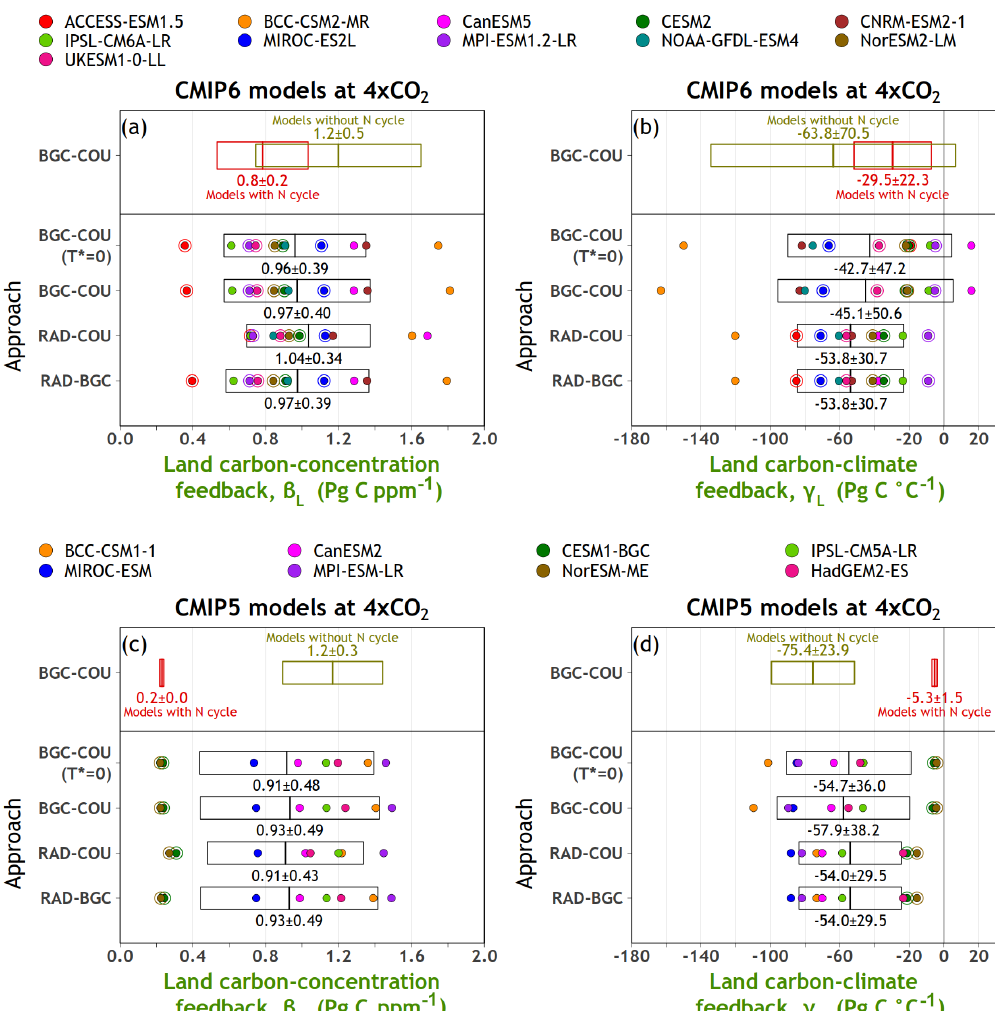
Figure 5. Carbon–concentration (a) and carbon–climate (b) feedback parameters over land from participating CMIP6 models calculated using the approaches summarized in Table 1. The boxes show the mean ± 1 standard deviation range, and the individual coloured dots represent individual models. Models which include a representation of the land nitrogen cycle are identified with a circle around their dot. The model mean ± 1 standard deviation range of feedback parameters is also separately shown for models which do and do not represent the land nitrogen cycle using the BGC–COU approach. Results from participating CMIP5 models in the A13 study are shown in (c) and (d)